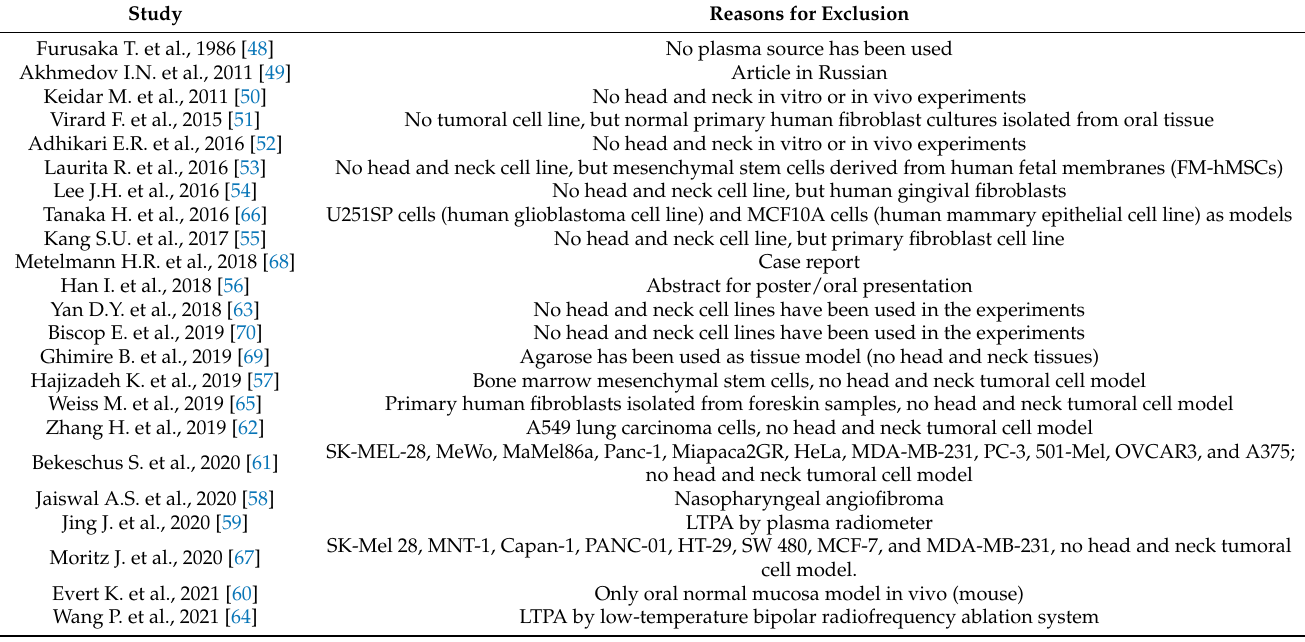
Table 1. List of excluded studies and reasons for